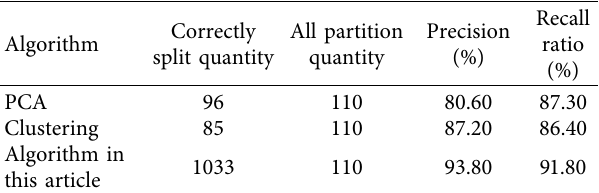
Table 5: Effect comparison of segmentation algorithms.